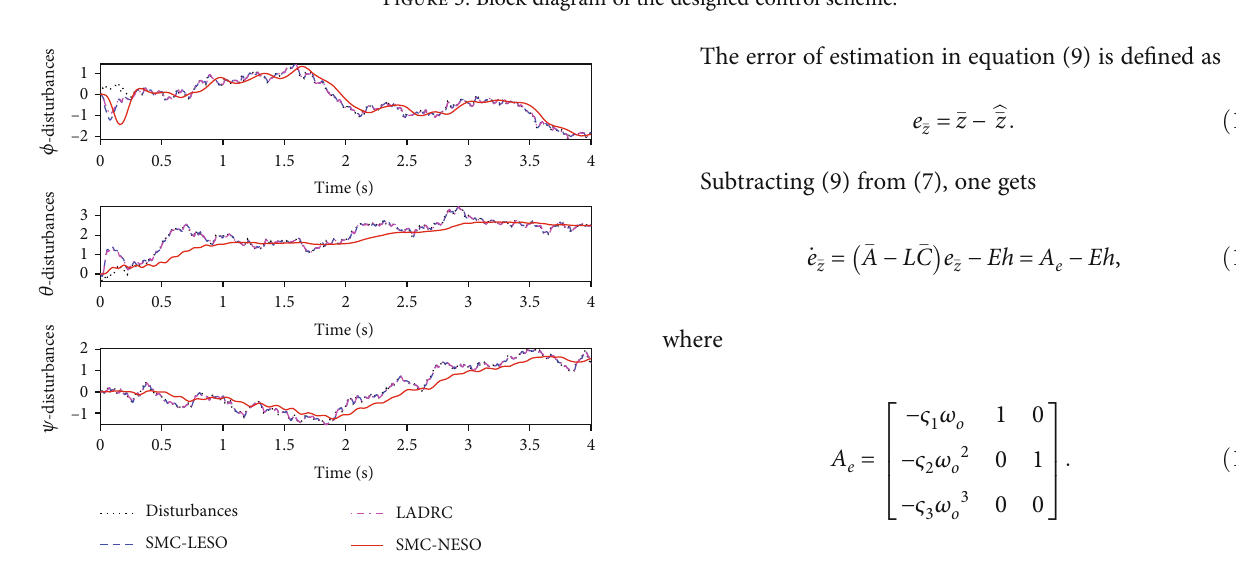
Figure 4: Observation results of the lumped disturbances.